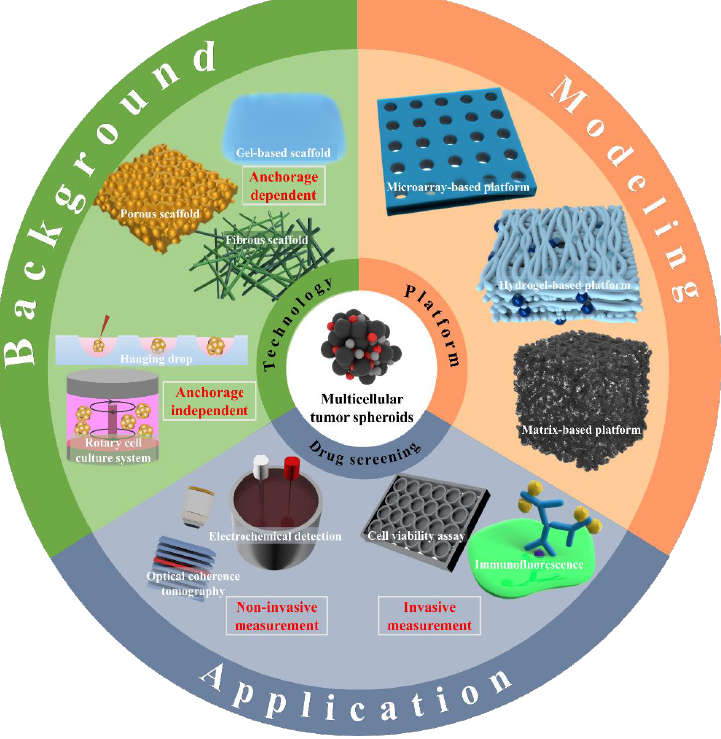
Figure 1. Multicellular tumor spheroid formation and drug screening through different approaches.